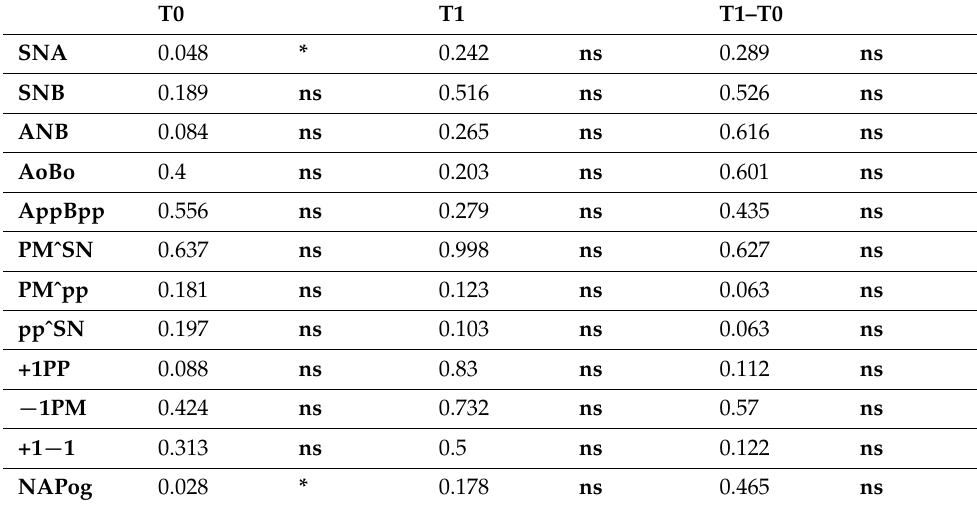
Results of the comparison between the two groups covered by the study and statistical